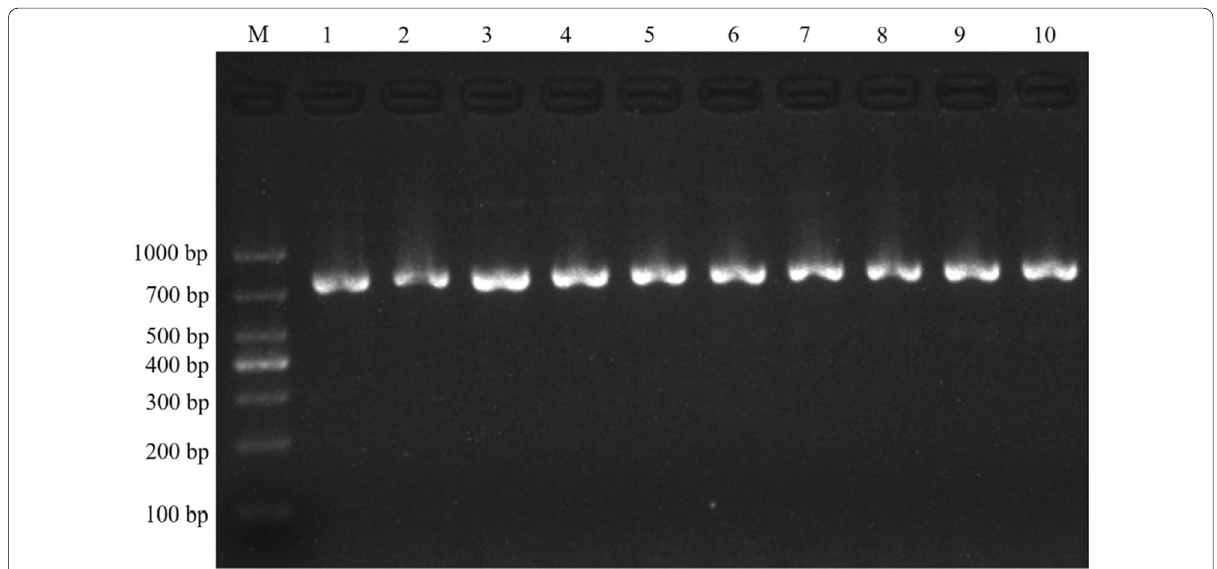
Fig. 5 Identification of the ten IgY-scFv antibodies. 1–10, IgY-scFv from randomly selected clones at the fourth bio-panning. M, DL 1000 DNA